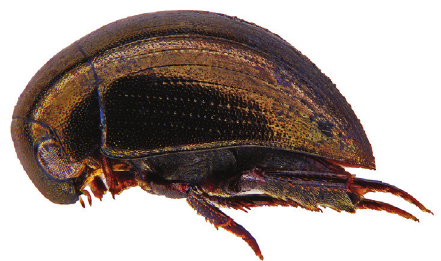
Figure 17. Regimbartia obsoleta (Régimbart, 1906) 3.8 mm, iSimangaliso Wetland Park, False Bay (site 27), January 2015 DT Bilton, MS Bird & R Perissinotto leg.